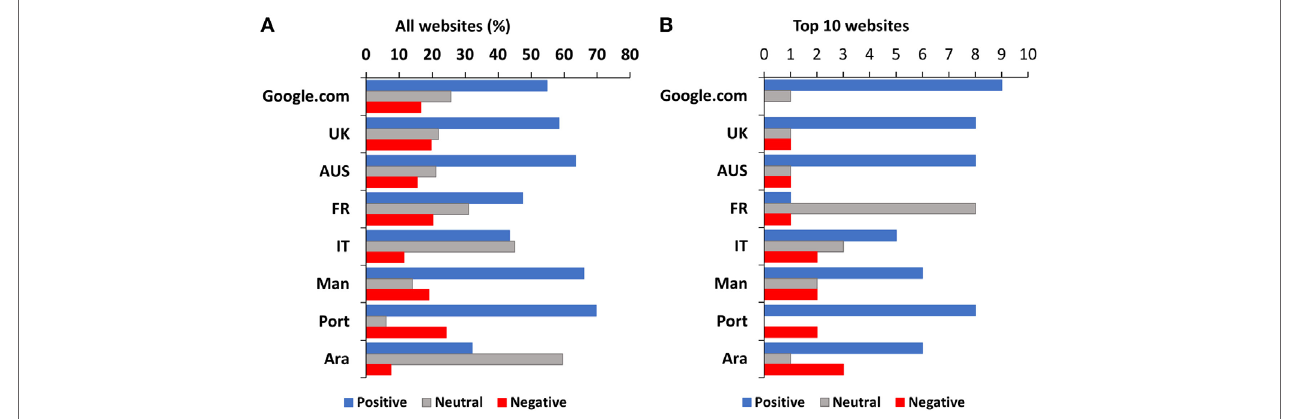
FigUre 2 | Webpages with different stance on vaccines in the entire search engine result page (a) and in the top 10 webpages (b) returned by Google. Data are expressed as percentage of websites for the entire search or number of websites in the top